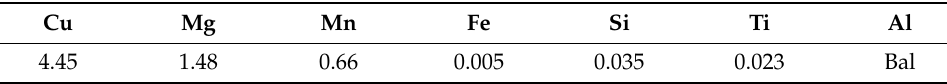
Table 1. The technical parameters of 2524 aluminum alloy